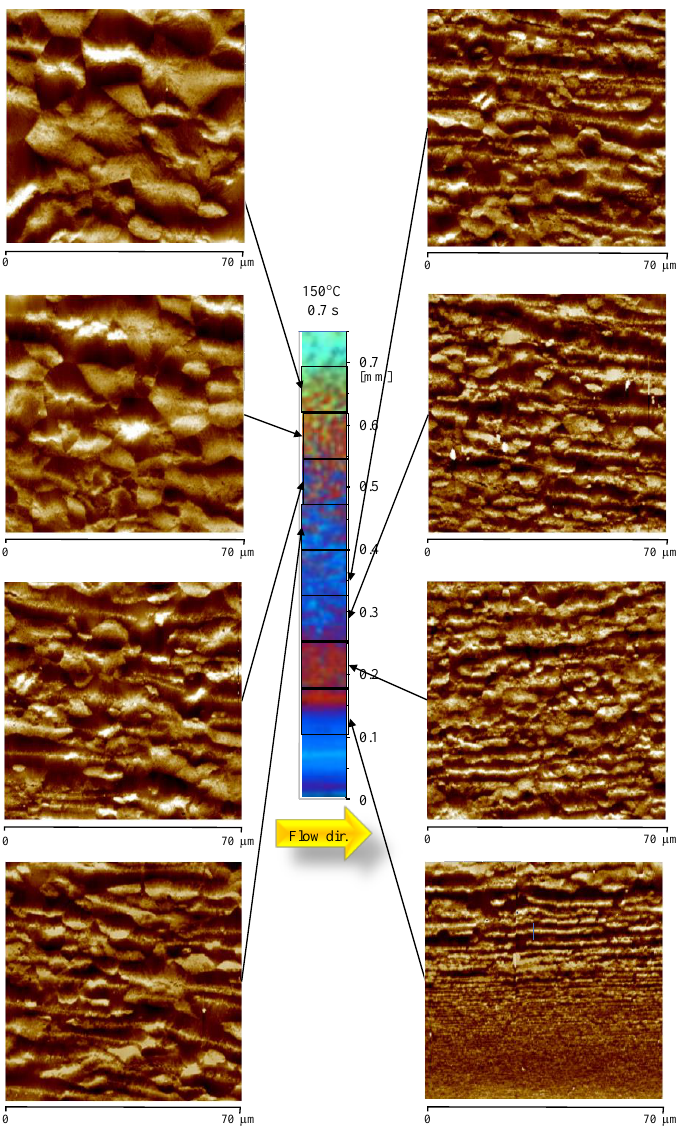
Figure 6. Optical micrograph and AFM height maps, at different distances from the sample surface, of the sample 150-07, at 15 mm downstream the gate.